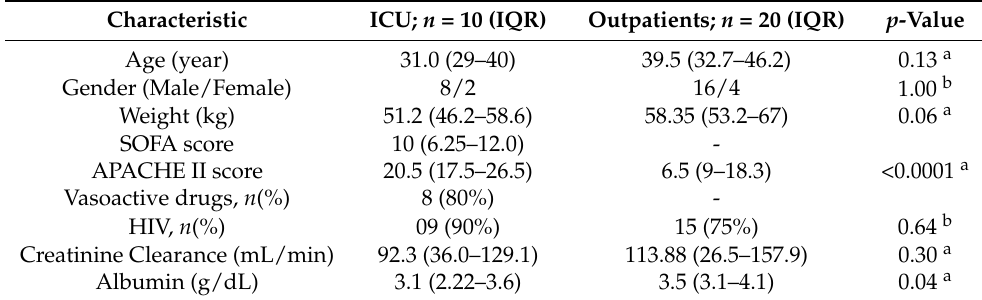
Table 1. Patients’ demographic and clinical characteristics.